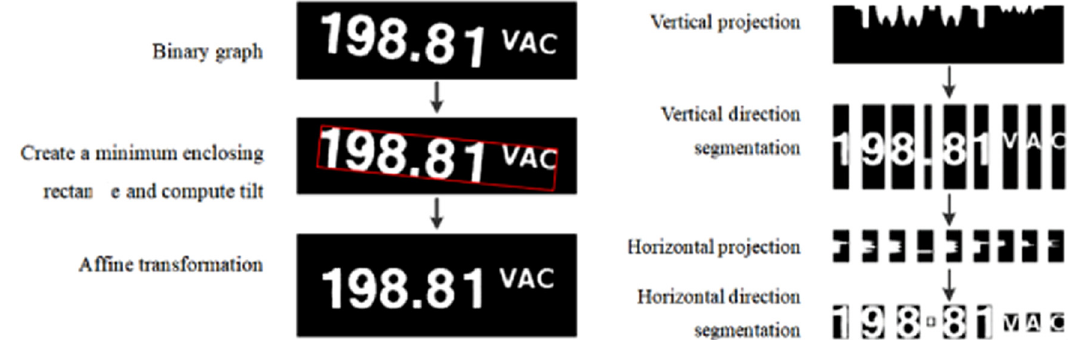
Figure 8: Segmentation e ff ect of the projection method.